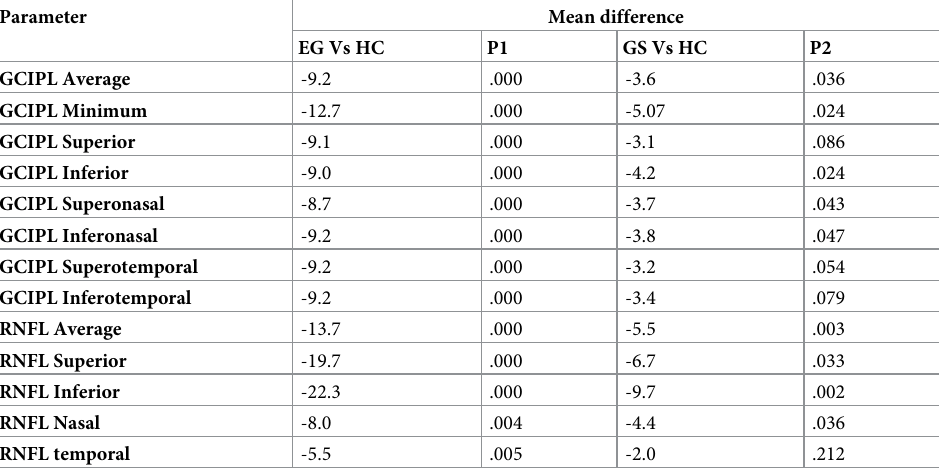
Table 3. The association of mean difference of GCIPL and RNFL parameters.